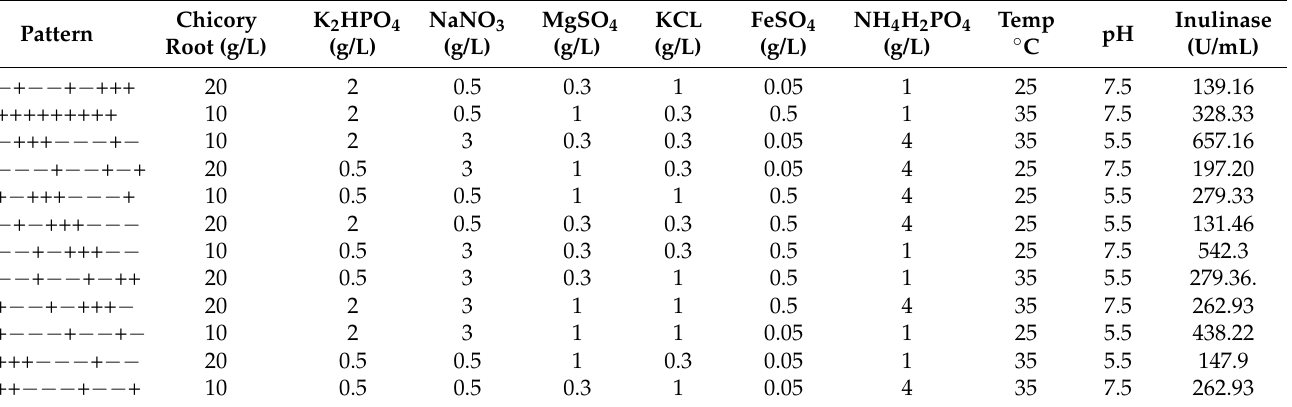
Table 4. Plackett–Burman experimental design matrix for screening of factors affecting inulinase production by Rhizopus oryzae NRRL 3563.